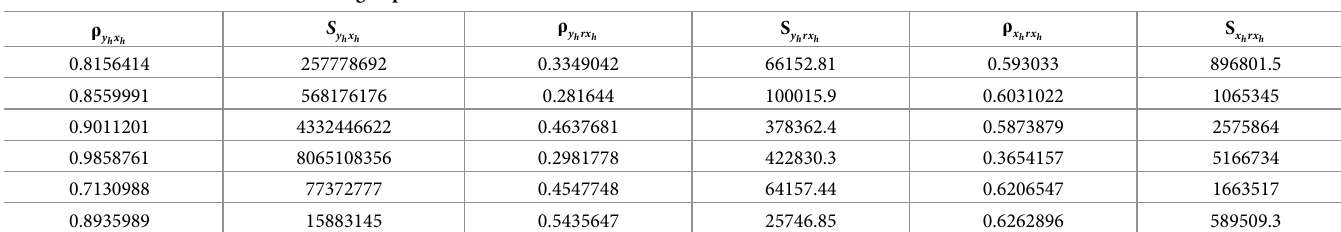
Table 5. Correlation and covariance’s using Population II. ρ y h x h